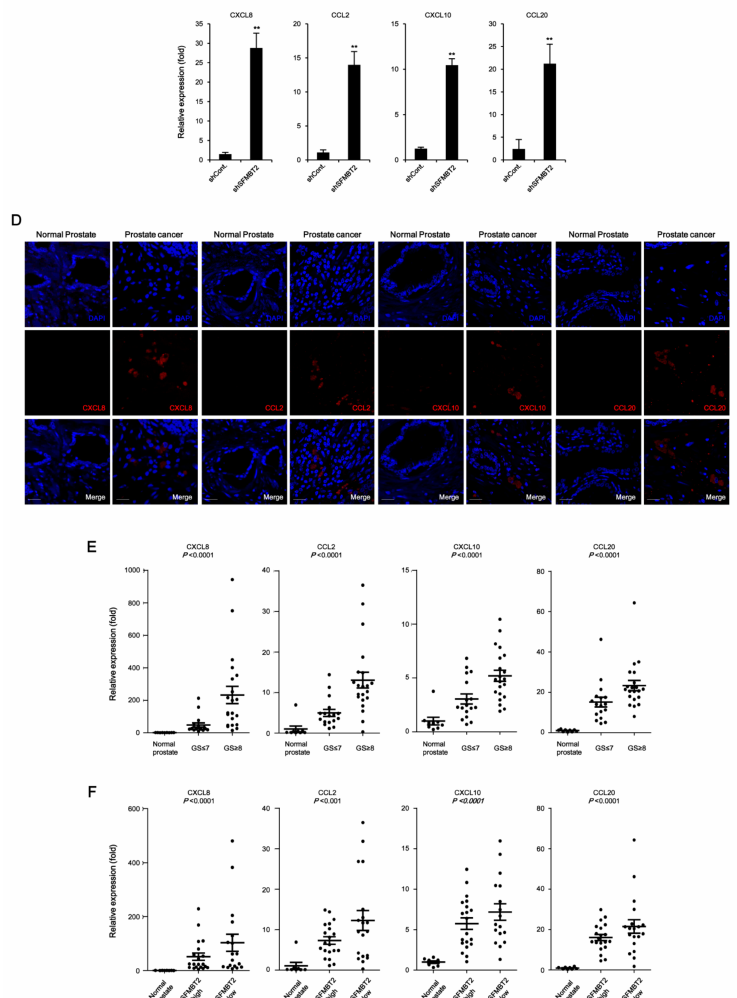
Figure 1. Down-regulation of SFMBT2 up-regulates the expression of chemokine genes in prostate cancer. ( A ) Increased expression of chemokines in LNCaP cells stably transfected with SFMBT2 shRNA. Culture media (CM) from LNCaP cells stably transfected with control (shCont) or SFMBT2 shRNA (shSFMBT2) were incubated with cytokine antibody array membrane. ( B ) Increased expression of CXCL8, CCL2, CXCL10, and CCL20 genes in LNCaP cells stably transfected with SFMBT2 shRNA. RNA was analyzed in LNCaP cells stably transfected with control or SFMBT2 shRNA. ( C ) Increased expression of CXCL8, CCL2, CXCL10, and CCL20 in prostate cancer induced by intraprostatic injection of LNCaP cells stably transfected with SFMBT2 shRNA. LNCaP cells (1 × 10 6 cells) transfected stably with control or SFMBT2 shRNA were injected into the prostate (dorsal lobe) of nude mice (n = 3 / group). At week 5 post-injection, the prostate was harvested, fixed, sectioned, and immunostained with anti-CXCL8, anti-CCL2, anti-CXCL10, and anti-CCL20 antibodies. Representative images are shown. Nuclei were identified using DAPI staining. Scale bar, 25 µ m. Expression was quantified using the ImageJ program. ( D ) Increased expression of CXCL8, CCL2, CXCL10, and CCL20 in prostate cancer tissues of patients. Immunohistochemical staining of a tissue array from prostate cancer patients was performed using anti-CXCL8, anti-CCL2, anti-CXCL10, and anti-CCL20 antibodies. Representative images are shown. Nuclei were identified using DAPI staining. Scale bar, 25 µ m. Expression was quantified using the ImageJ program. ( E ) Proportional relationship of Gleason scores (GS) with the expression level of CXCL8, CCL2, CXCL10, and CCL20 in prostate cancer tissues of patients. ( F ) Inverse relationship of SFMBT2 expression with the expression level of CXCL8, CCL2, CXCL10, and CCL20 in prostate cancer tissues of patients. All data represent mean ± S.E.M. Significance values were ** p ≤ 0.01 and *** p ≤